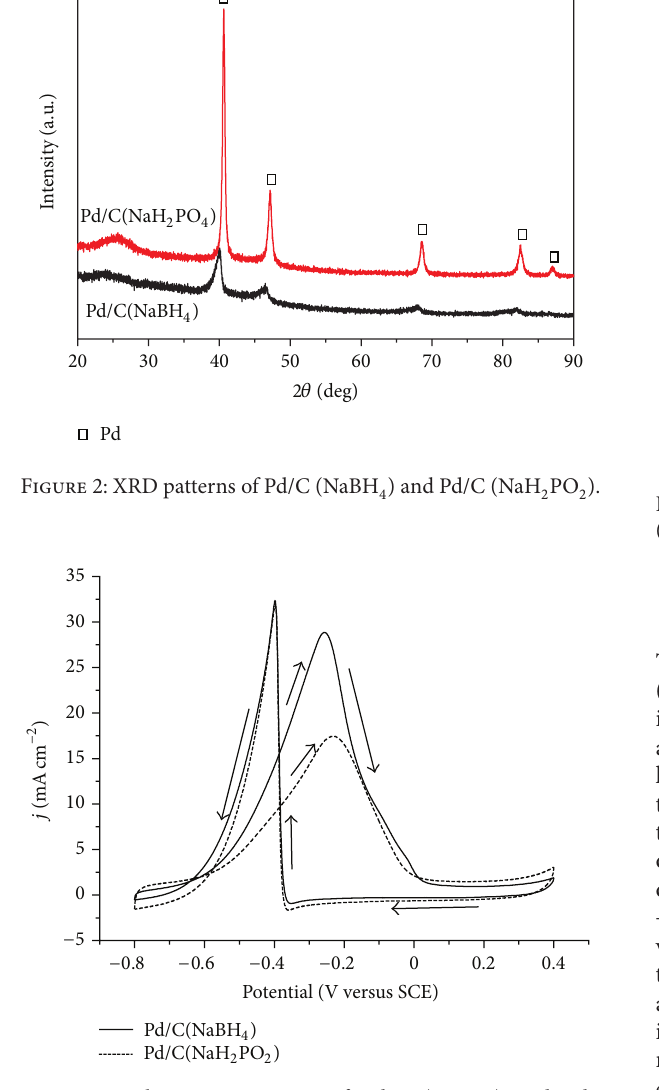
Table 2: Comparison of activity of ethanol oxidation between Pd/C ) and Pd/C (NaH (NaBH 4 Catalyst